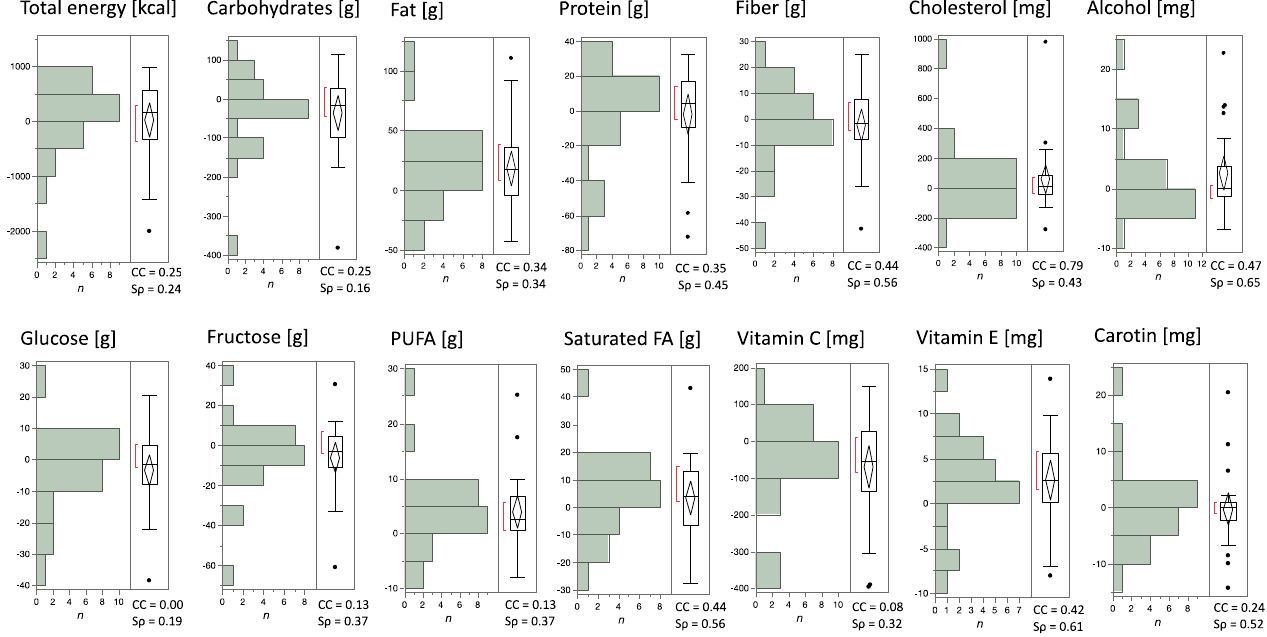
Figure 5. Concordances and differences between 24dr and DEGS-FFQ nutrient intake estimates for total energy, certain nutrients, and dietary fiber. Values of the calculated concordance and Spearman correlation; the data are from both groups at T 2 ( n = 24). PUFA = polyunsaturated fatty acids, FA = fatty acids, n = number, 24dr = 24 h dietary recall, FFQ = DEGS Food Frequency Questionnaire.